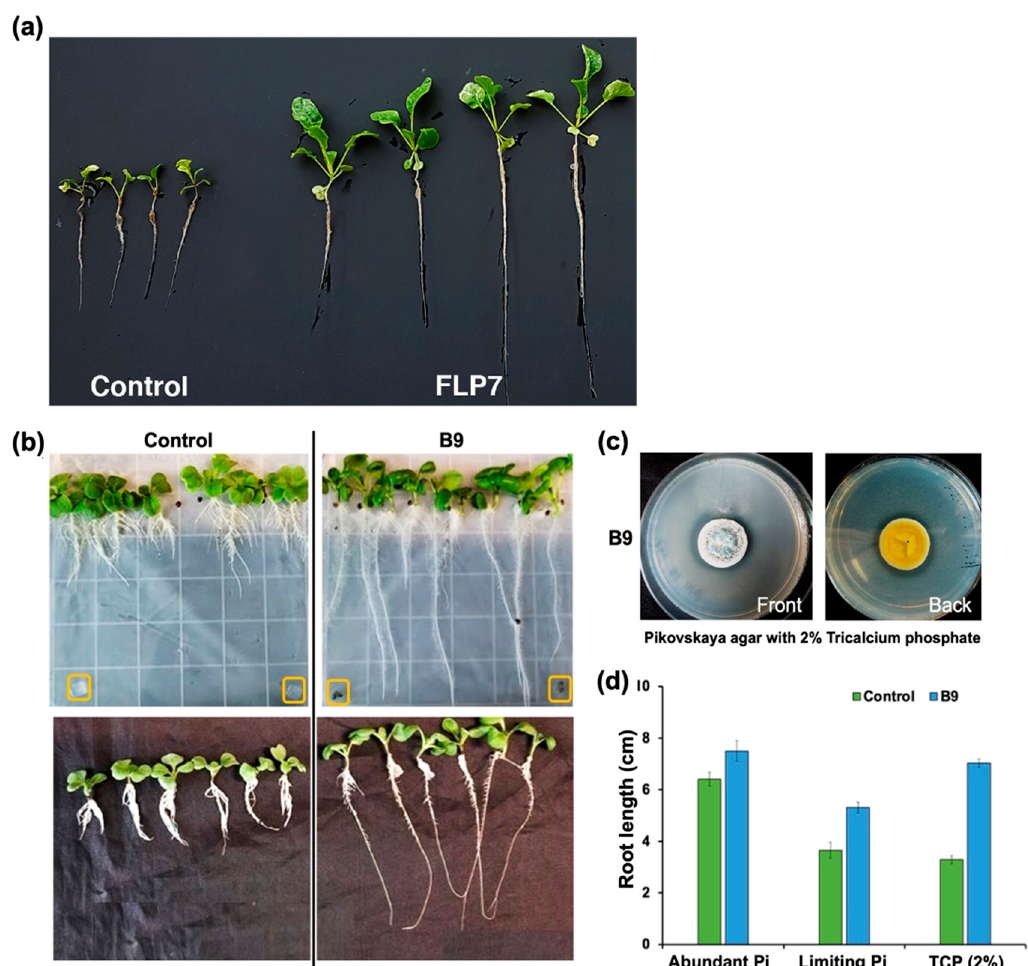
Figure 2. P. citrinum enables robust root and shoot growth in Choy Sum under phosphate (Pi)-limiting conditions. ( a ) The morphological traits of Choy Sum treated with FLP7 conidia or with water as control. The average leaf area (cm 2 ), root length (cm), the dry weight of roots and aerial parts (mg) determined from both FLP7-treated seedlings and the mock control plants were determined and mentioned in the Section 3. Data represents means ± SDs from 3 replicates consisting of 8 plants in each instance. ( b ) The morphological traits of Choy Sum treated with B9, or with water as control in phosphate-limiting conditions in MS agar (top panels; B9 provided as mycelial plugs (boxed in yellow) or in soil (lower; B9 provided as conidia suspension). Control refers to treatment with water or uninoculated medium plugs (only) in the absence of the fungal mycelia/conidia. The average leaf area (cm 2 ), root length (cm), the dry weight (mg) of roots and aerial parts were determined from both B9-treated seedlings and the mock control plants. Data represents means ± SDs from 3 replicates consisting of 16 plants in each instance. ( c ) P. citrinum helps assimilate phosphate and enables its bioavailability to the host plants. B9 is capable of solubilizing tricalcium phosphate, as judged by the zone of clearance around edges of the B9 colony cultivated on Pikovskaya agar containing 2% Ca 3 (PO 4 ) 2 . ( d ) P. citrinum provides solubilized phosphate to host plants to induce root growth in Pi-limiting conditions. Bar graph quantifying average root length in Choy Sum plants grown in the presence of phosphate-replete or phosphate-limiting conditions in the presence or absence of the P. citrinum B9